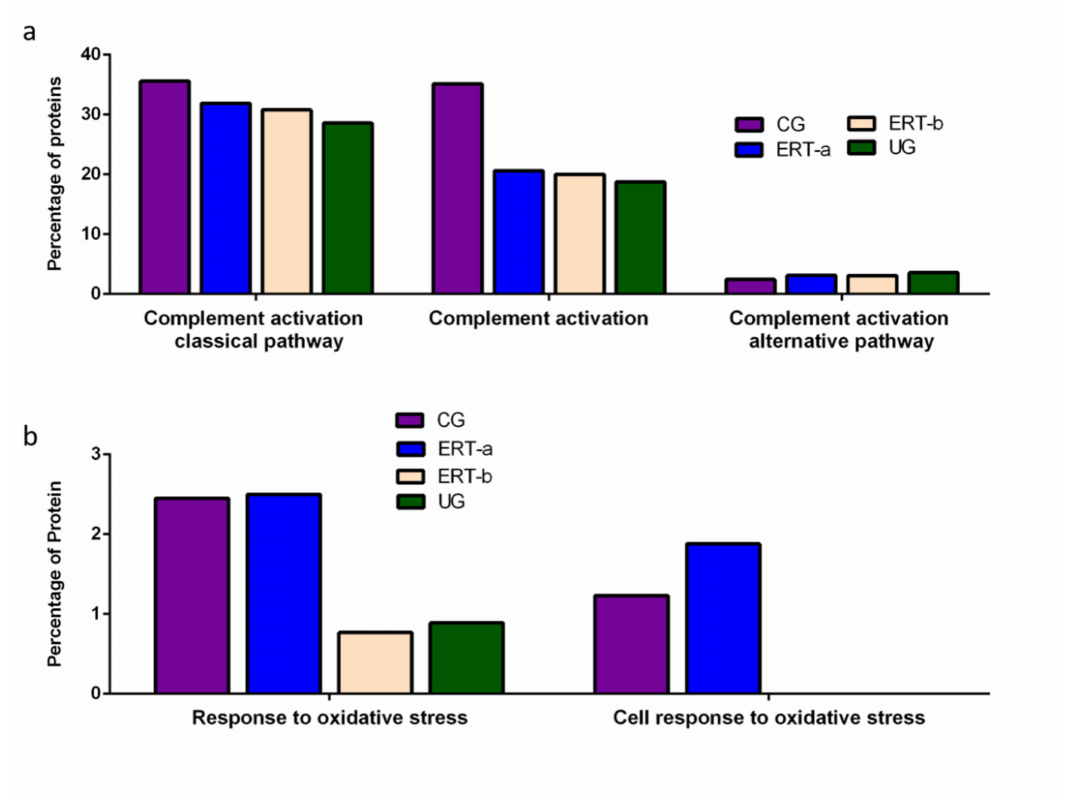
Figure 6. Functional enrichment analysis using FunRich. Proteins identified in each of the different groups were submitted to molecular functional analysis according to their involvement in immune processes: proteins involved in the classical or alternative complement activation pathways ( a ); proteins involved in the response to oxidative stress ( b ).